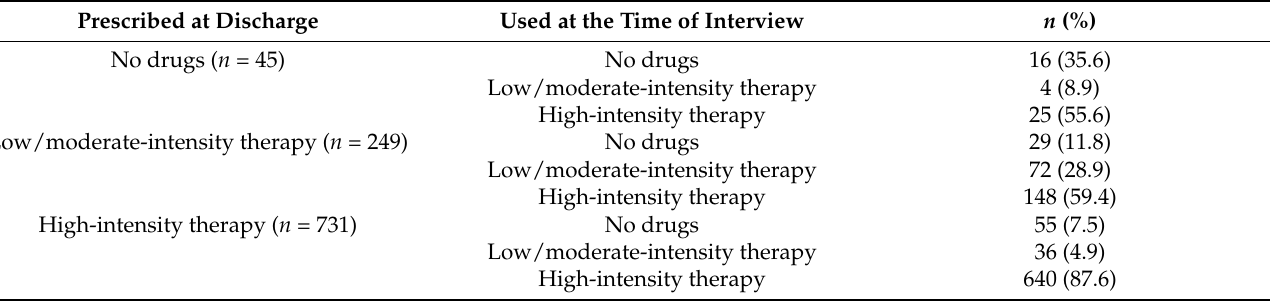
Table 3. Change in the lipid-lowering therapies from discharge to the follow-up examination. Prescribed at Discharge Used at the Time of